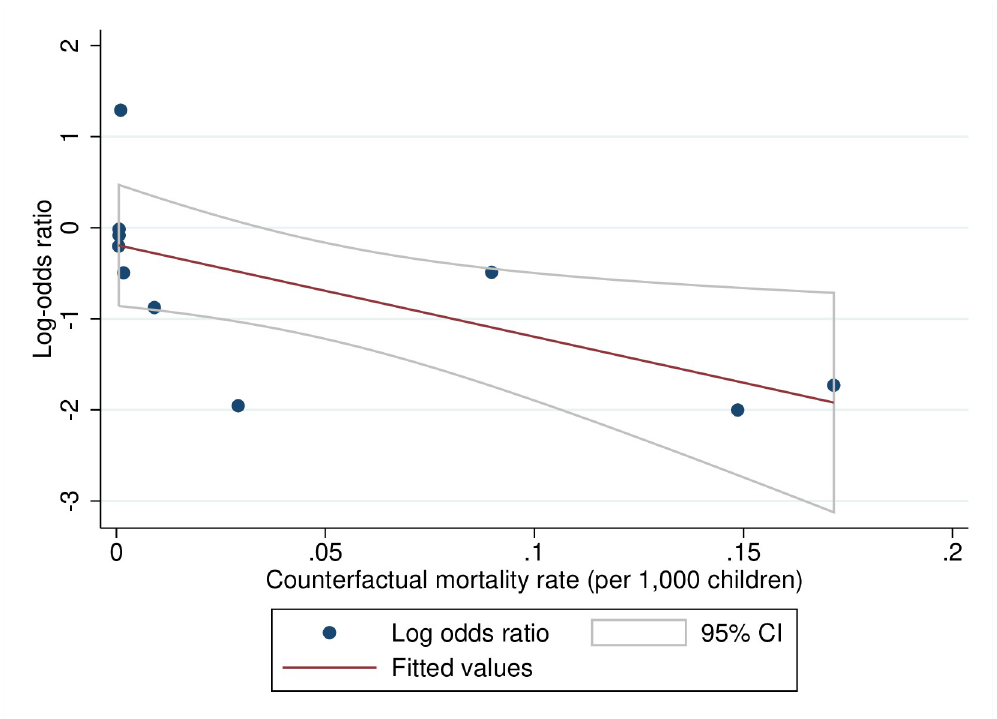
Fig 11. Meta-regression plot of diarrhoea mortality in childhood against prevalence. Note: Fitted values are from inverse- variance weighted regression.